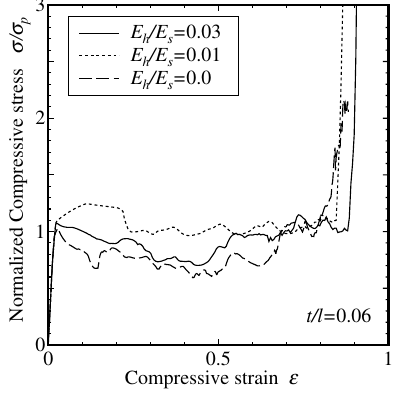
Figure 4. Stress-strain responses of a finite honeycomb with t/l = 0 . 06